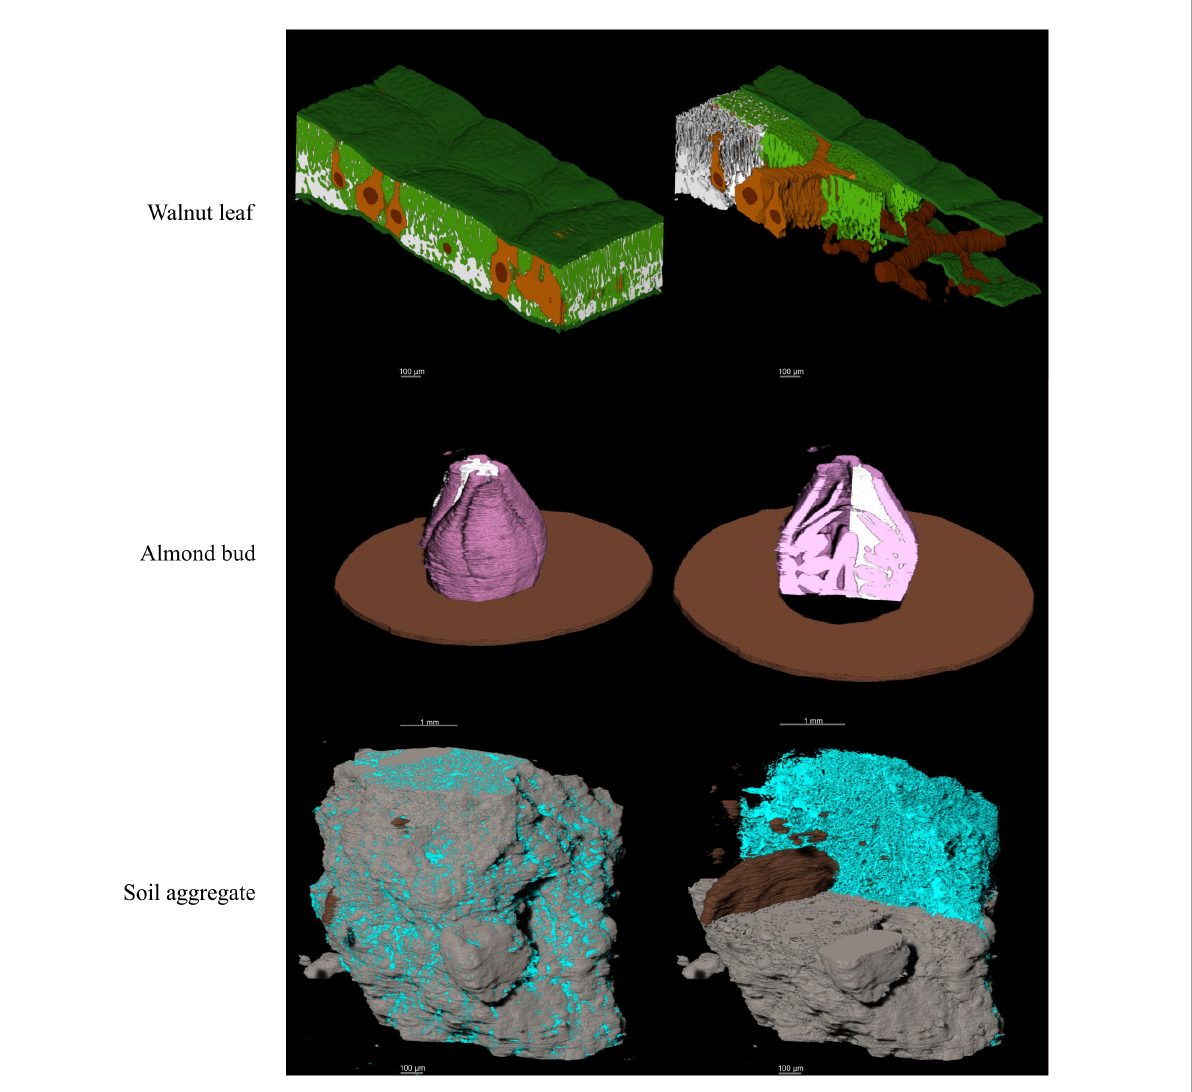
FIGURE7 3D visual representation of the stacked model outputs for a walnut leaf, an almond flower bud, and a soil aggregate; top images are X-ray CT scans of the bud and soil aggregate; next are the hand. In the walnut leaf images, the background is black, the epidermis is dark green, the mesophyll is light green, the air space is white, the bundle sheath extensions burnt orange, and the veins are brown. In the almond bud images, background is black, bud scales are brown, flower tissue is pink, and air spaces are white. For the soil aggregate, background is black, mineral solids are dark gray, pore spaces are blue, and organic matter is